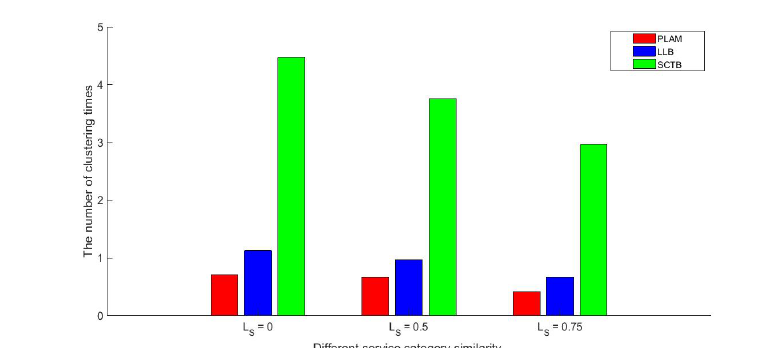
Figure 15. The simulation results for